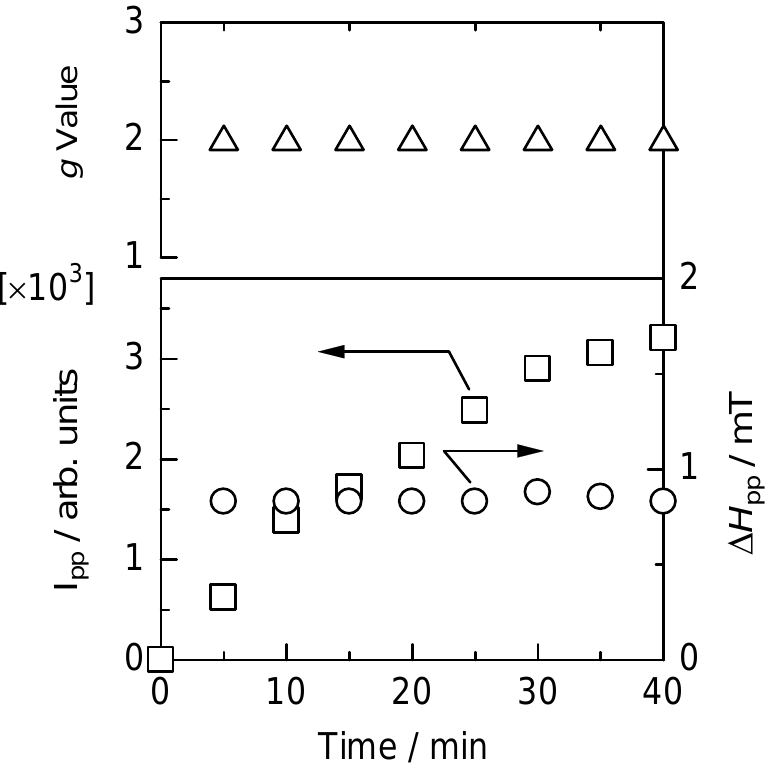
Figure 12. ESR intensity, g value, and linewidth of the ESR signal for polyPLC3Th during in-situ vapor-phase iodine